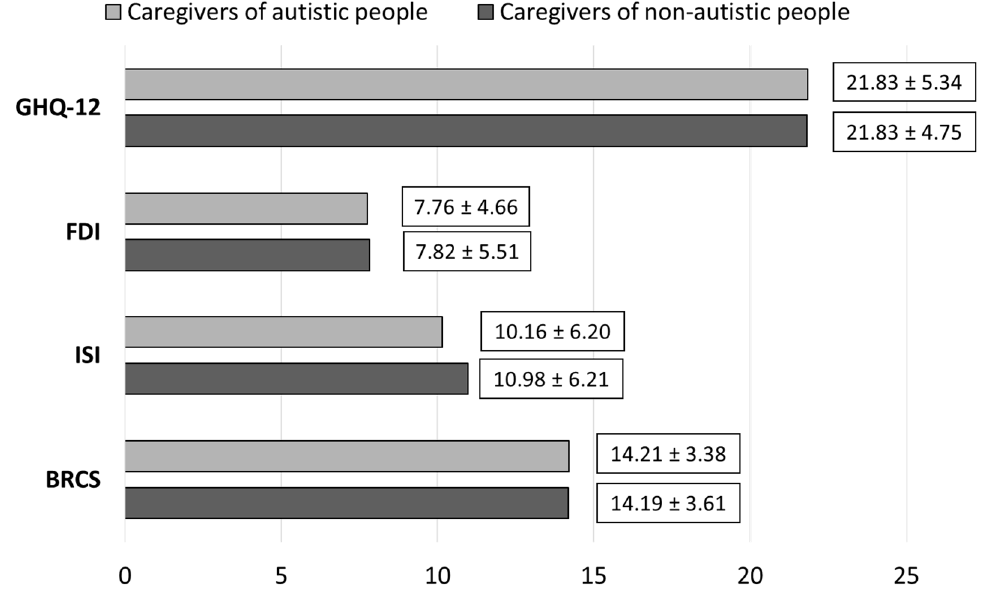
Figure 1. Mean scores ± standard deviations in psychological wellbeing (GHQ ‐ 12), family distress (FDI), insomnia (ISI), and resilience (BRCS) reported by caregivers of autistic and non-autistic people. Legend: BRCS: Brief Resilience Coping Scale; FDI: Family Distress Index; GHQ ‐ 12: General Health Questionnaire ‐ 12 items; ISI: Insomnia Severity Index.